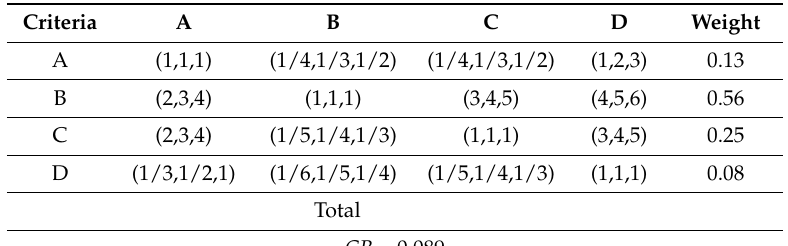
Table 5. Fuzzy comparison matrices for criteria.